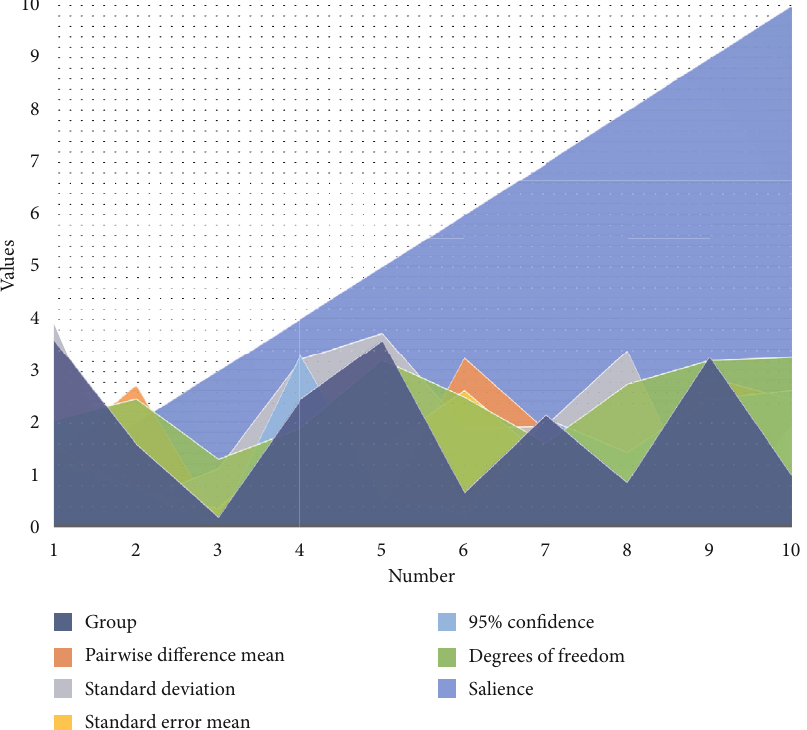
Figure 7: Intragroup comparison of inhibition ability in the experimental